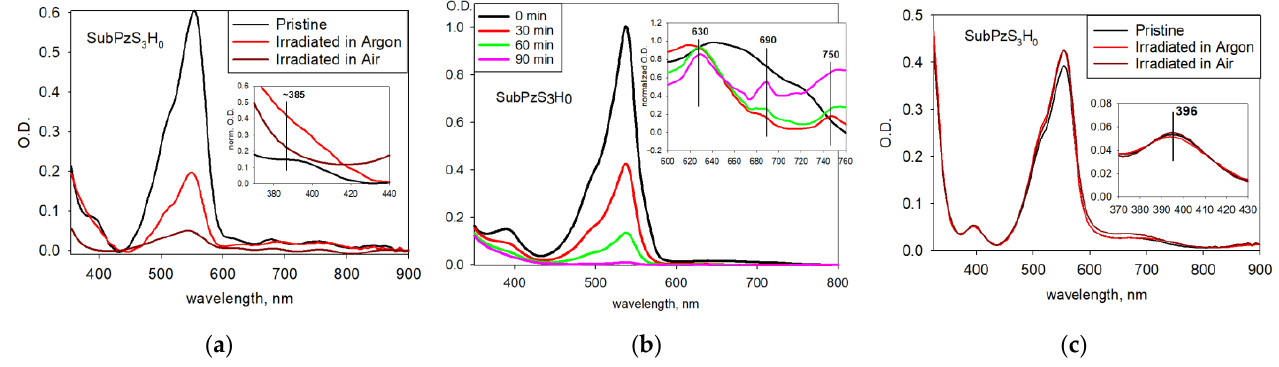
Figure 6. Spectra of SubPzS 3 H 0 films on PET/ITO substrate before and after direct sunlight irradiation either in air or in argon ( a ); Time-resolved absorption spectra of SubPzS 3 H 0 solution in acetone in presence of In(Acac) 3 before (black) and after (red, green, pink) direct illumination in argon (inset— normalized 600–760 nm region) ( b ); Spectra of SubPzS 3 H 0 films on glass/FTO substrate before